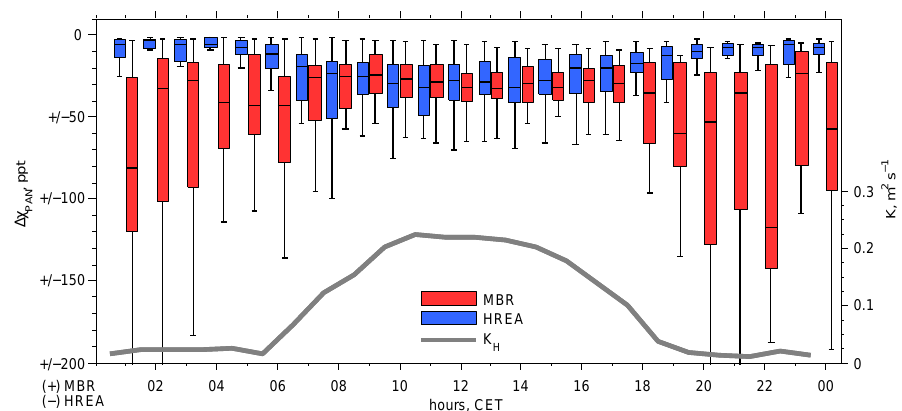
Figure 4. The expected absolute PAN mixing ratio differences using both the HREA and MBR method presented as diurnal cycles using hourly boxplot statistics. Shown are the results from the simulation based on data from the Mainz-Finthen grassland site for the period from 1 August to 30 September 2011. In addition, the median turbulent exchange coefficient K H is displayed, which was calculated with the aerodynamic approach using the universal stability functions for the sensible heat flux of Businger et al. (1971) modified by Högström (1988). For most of the night-time differences for the MBR method the turbulence criterion (i.e. u ∗ < 0.07ms − 1 according to Liu and Foken, 2001) is not fulfilled and the flux calculation is not